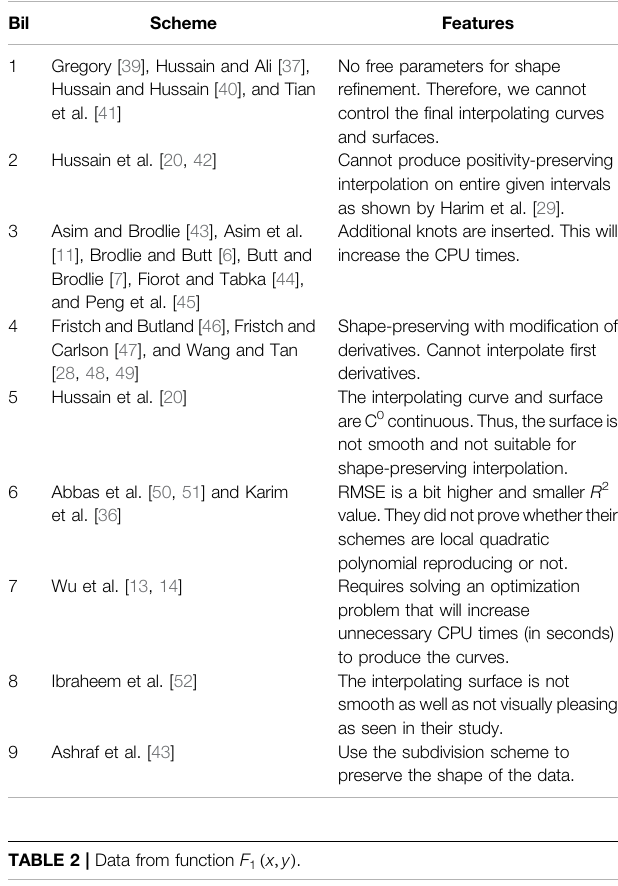
TABLE 1 | Comparison of shape-preserving schemes.